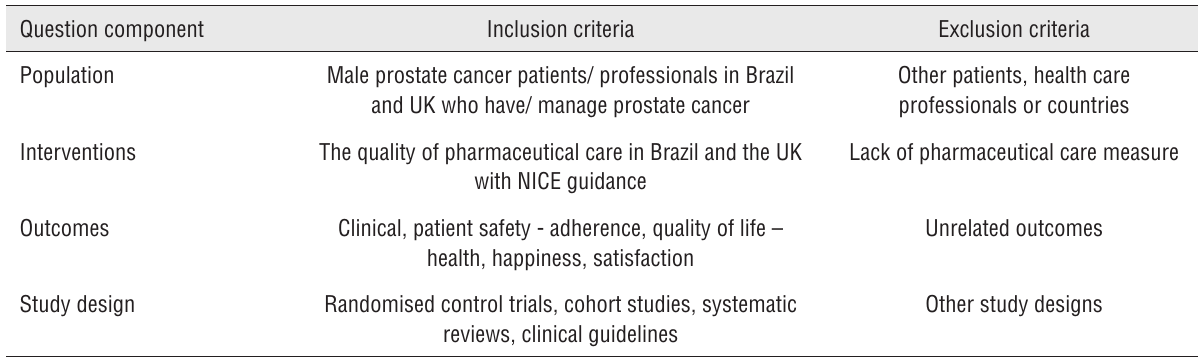
Table 2 – Inclusion and exclusion criteria of